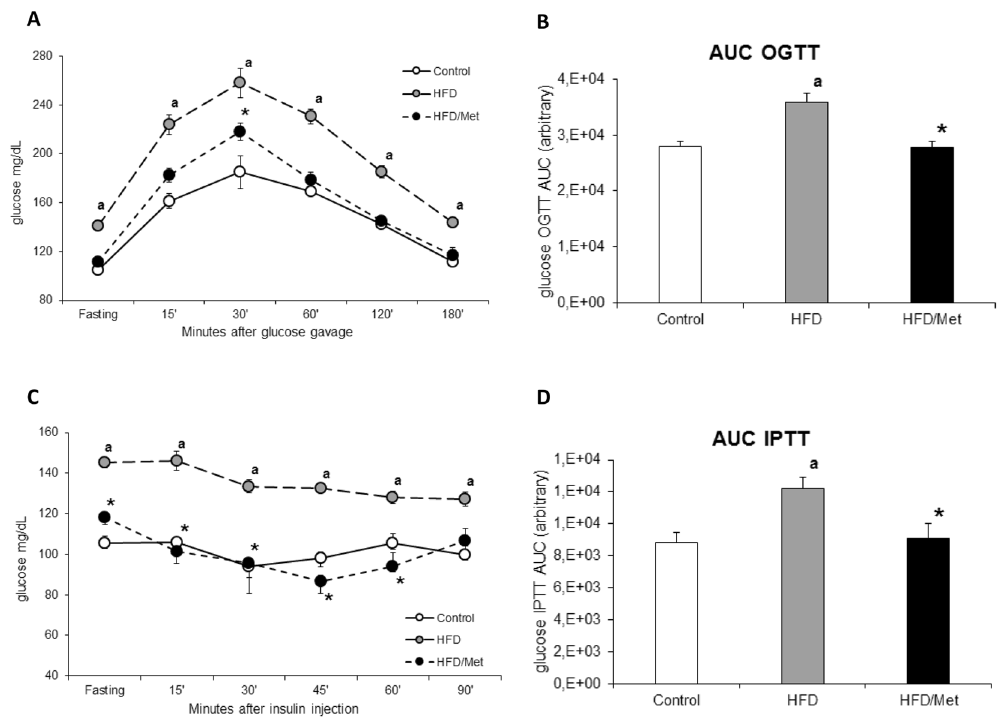
Figure 1. Treatment with metformin improves glucose and insulin tolerance in animals on high-fat diet. Panel A shows blood glucose profiles during oral glucose tolerance test (OGTT); Panel C shows blood glucose profiles during intraperitoneal insulin tolerance test (IPTT). Panels B and D show respective areas under blood glucose concentration curve (AUC) from OGTT and IPTT tests. Values are mean + / − SD. Symbols denote statistical significance of p < 0.05 against: a- vs. Control group; * - vs. HFD group, n = 8 per group; Significance by Anova with Tukey HSD post-hoc